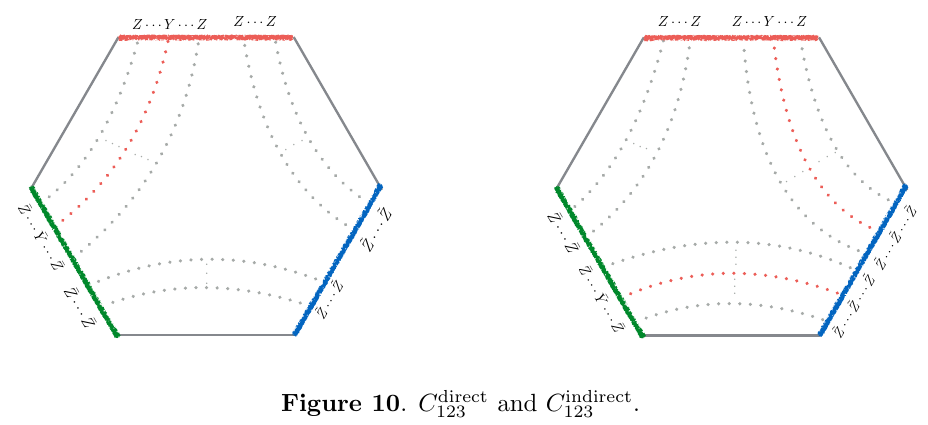
and C indirect 123 123